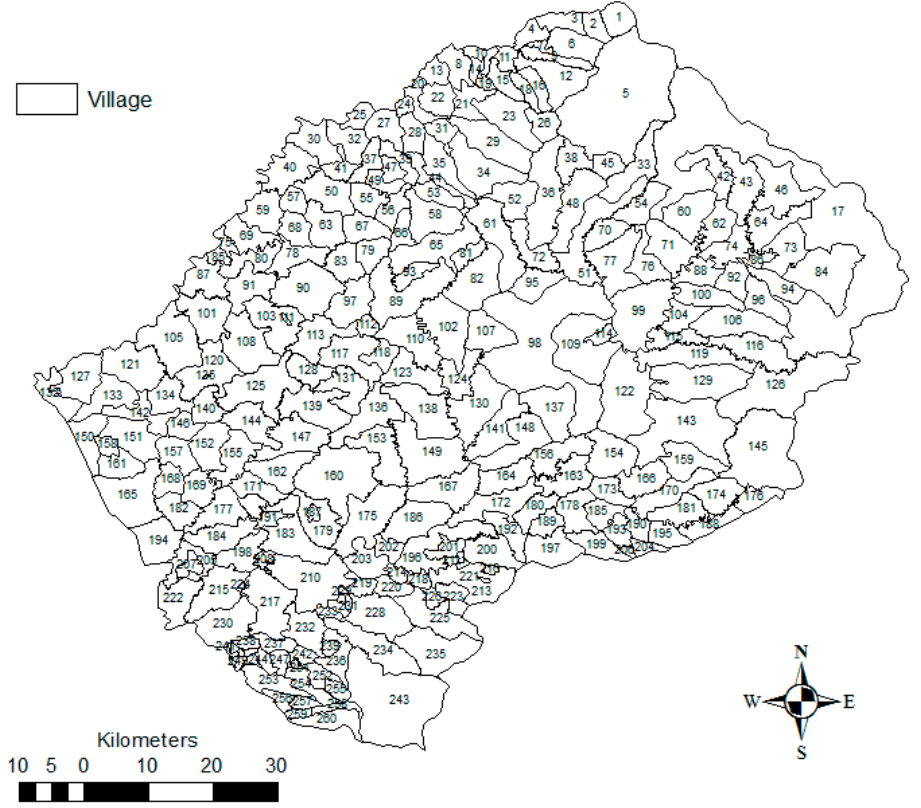
Figure 2. Map of Lesotho showing the boundaries of the smallest administrative areas, villages (see Annex 1 for corresponding village names).